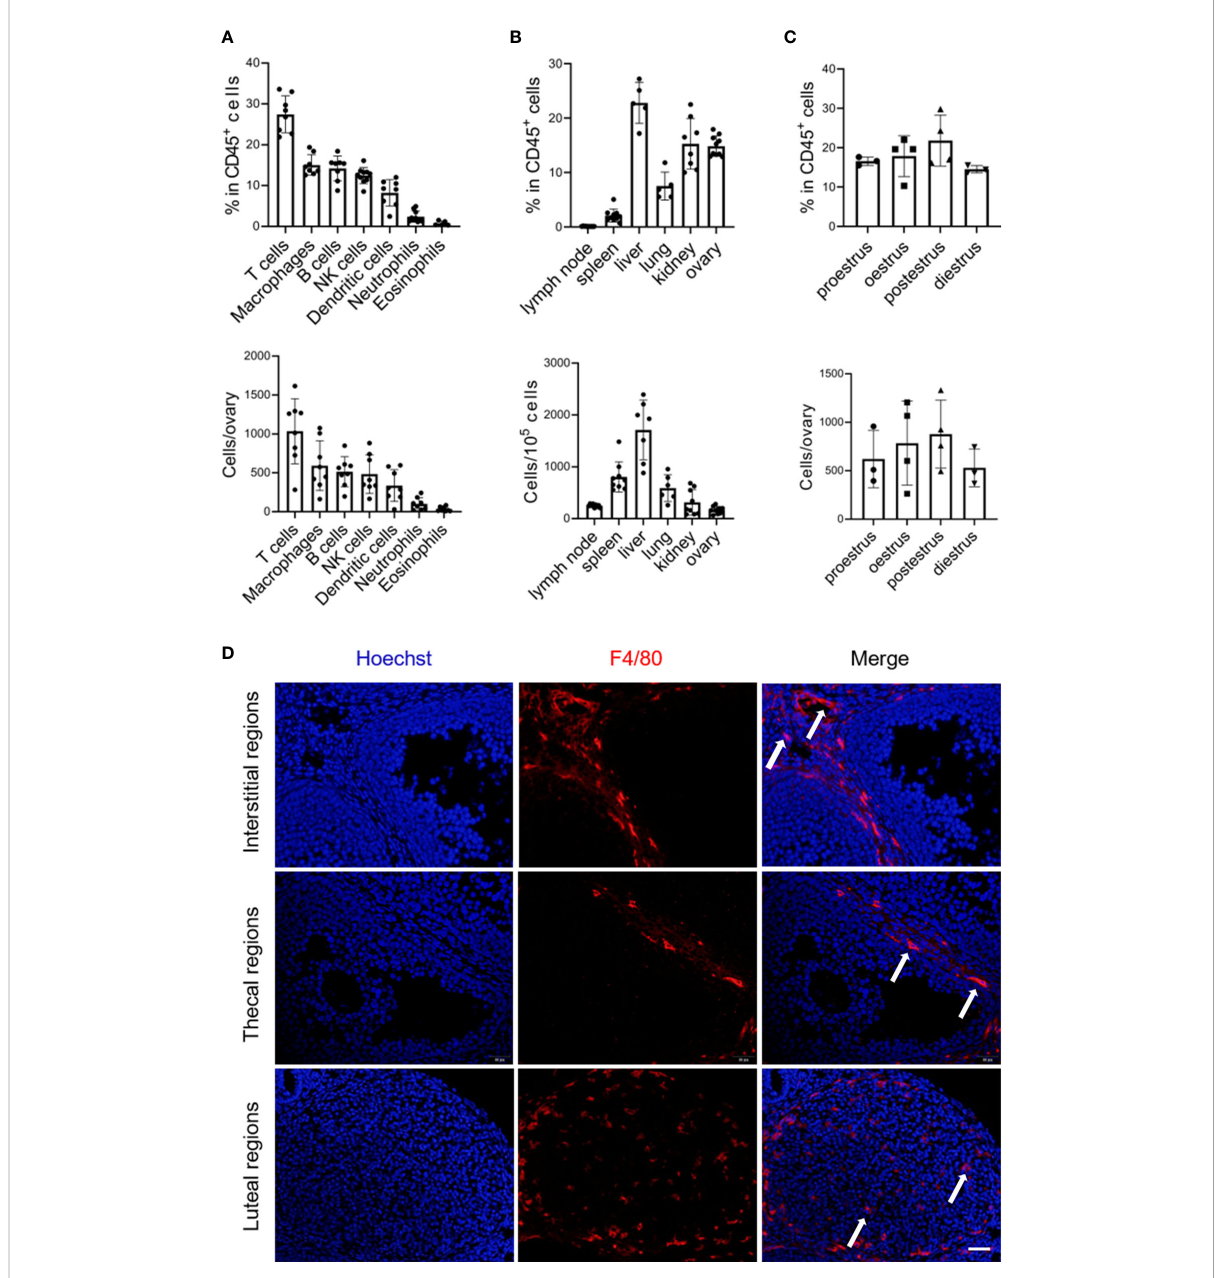
FIGURE 1 Abundance and localization of macrophages within the adult ovary. (A) Graphs show the proportion and number of immune cell subsets, derived from fl ow cytometry in Figure S1 (n=8. Mean ± SEM). (B) Flow cytometry analysis of macrophage percentages and numbers in the mouse lymph node, spleen, liver, lung, kidney, and ovary (n=5~9. Mean ± SEM). (C) The frequencies and numbers of ovarian macrophages at the different periods of the mouse estrous cycle, each dot represents data from 4 individual mice pooled together (n=3~4. Mean ± SEM). (D) Immuno fl uorescent detection of F4/80 in the ovaries of 8-week-old mice. Arrows show ovarian macrophages. Scale bar 20 m